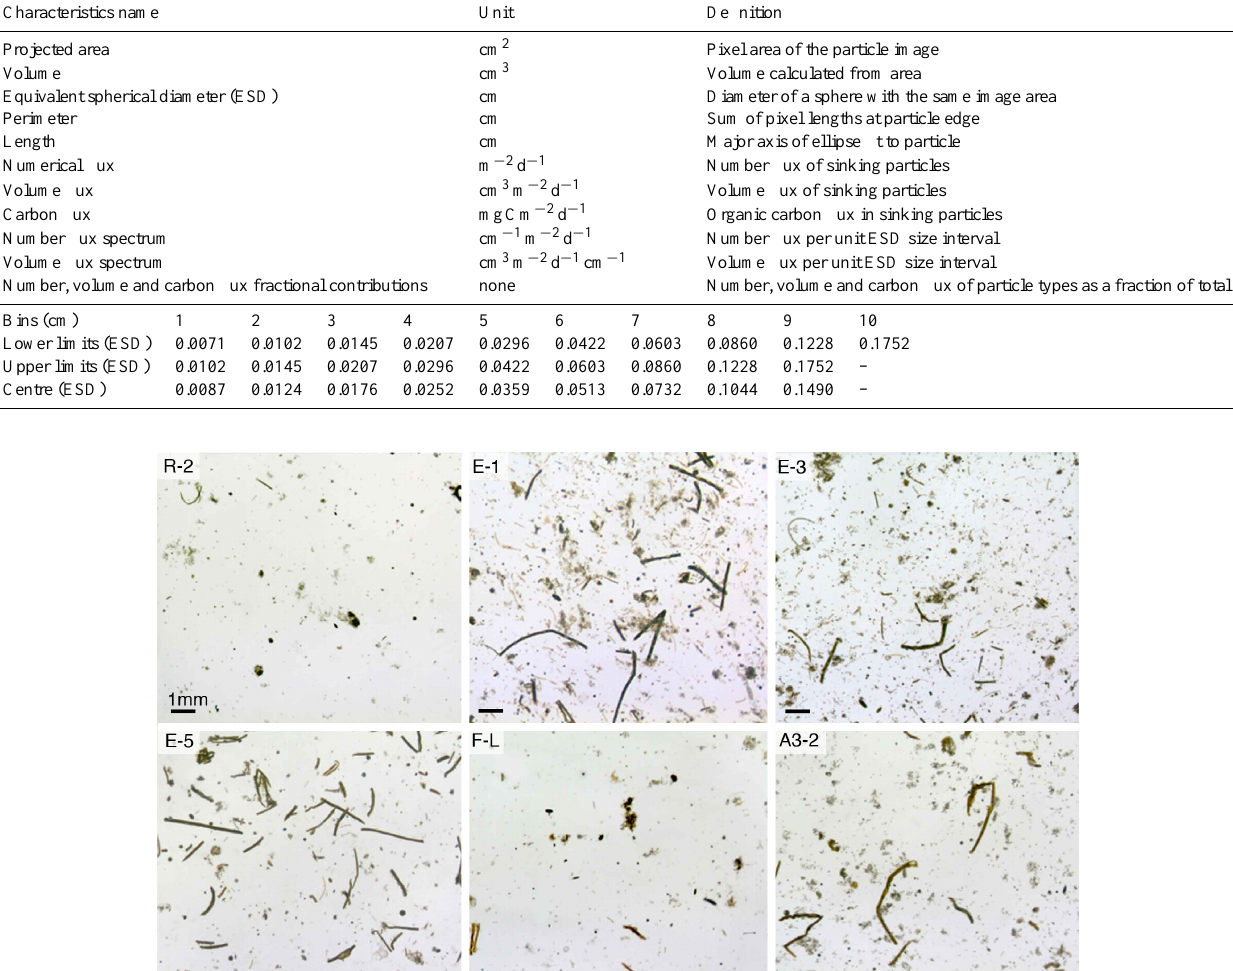
Table 2. Particle characteristics and bins for phytodetrital aggregates, cylindrical fecal pellets and fecal aggregates.